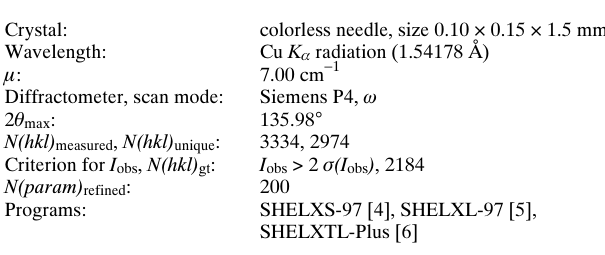
Table 1. Datacollection and handling.